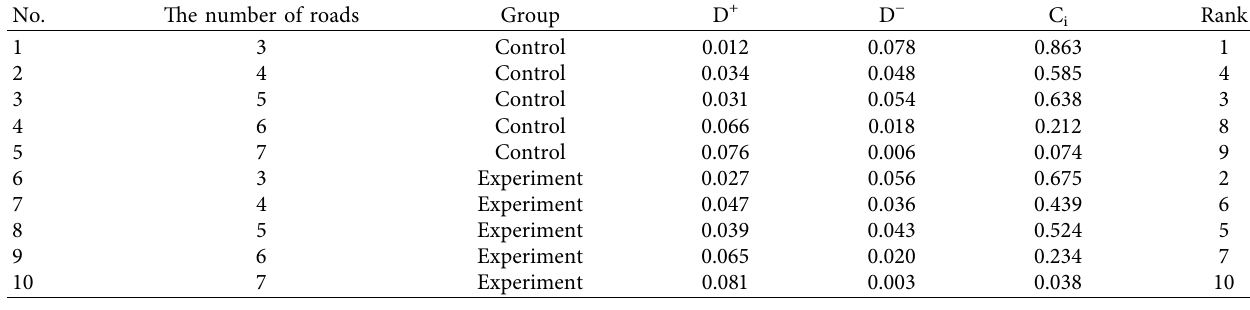
Table 4: Ranking results of diferent evaluation indexes and their optimal